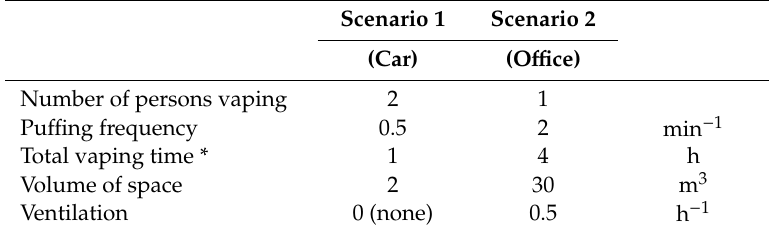
Table 4. Parameters defining the two scenarios for which bystander exposure was estimated.